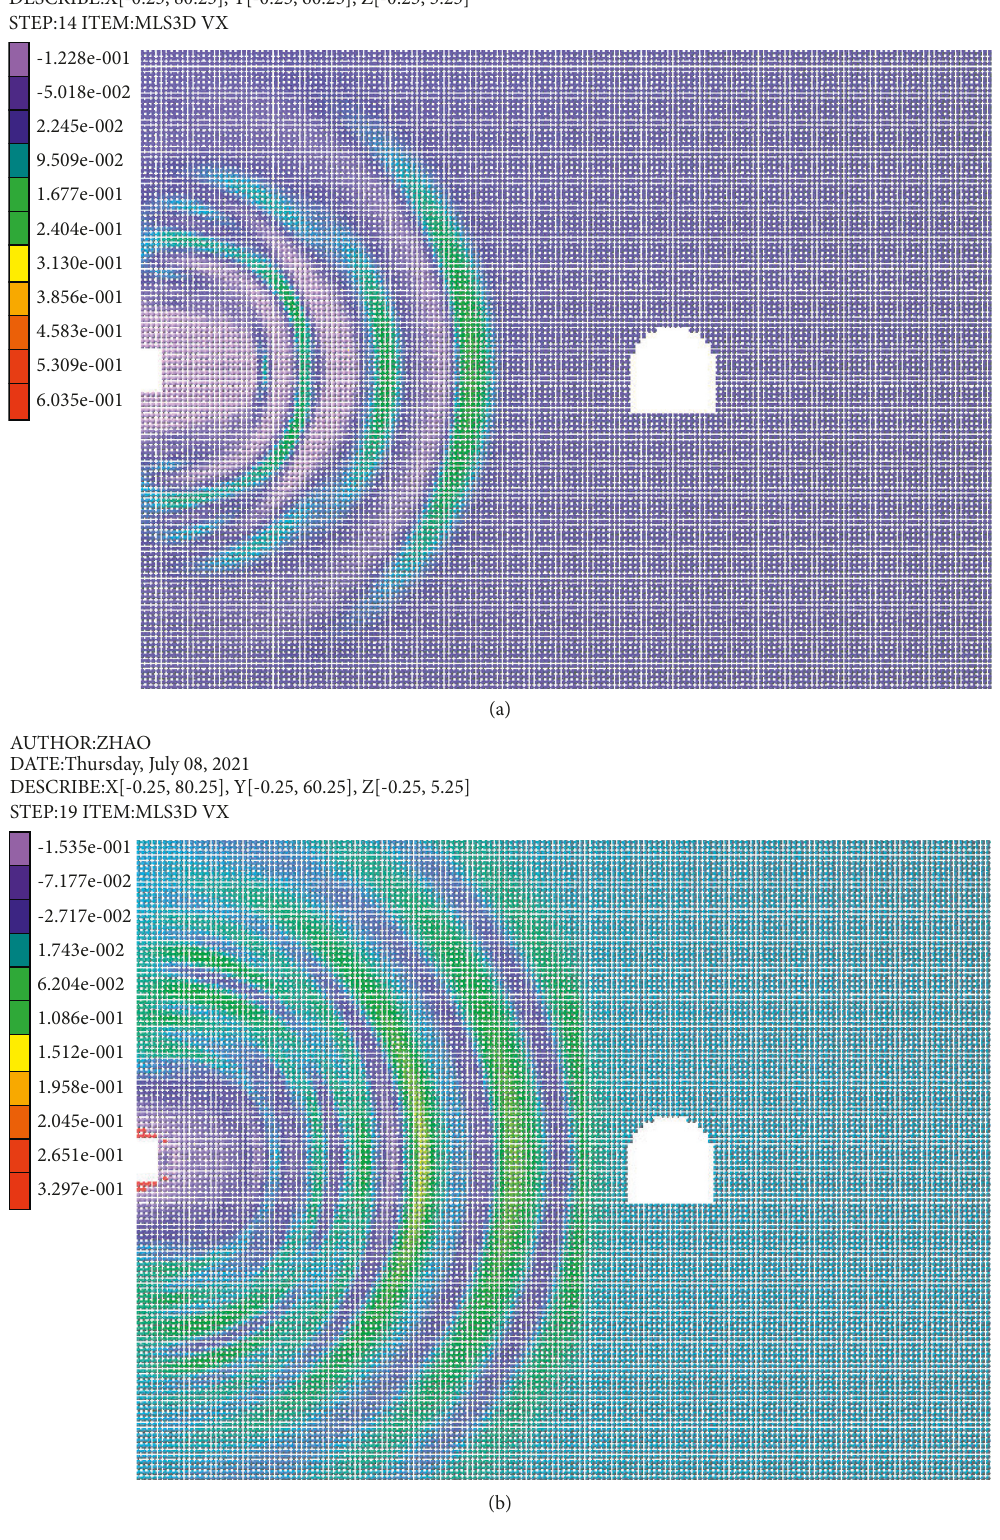
Figure 5: Cloud chart of stress wave transmission when (a) t � 6ms and (b) t �